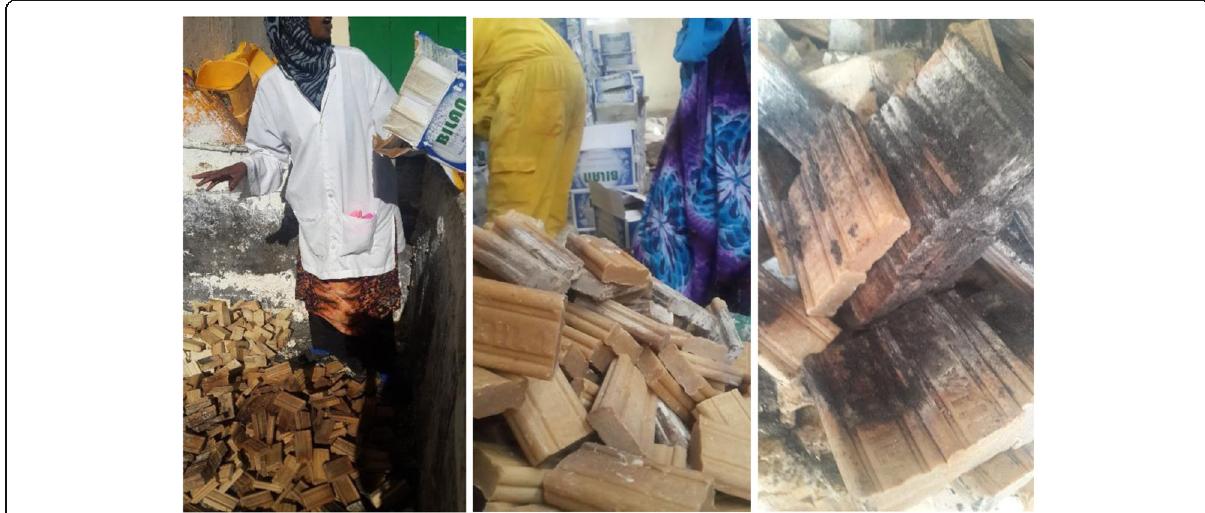
Figure 4 Photos of the returned spoiled soap due to fungal